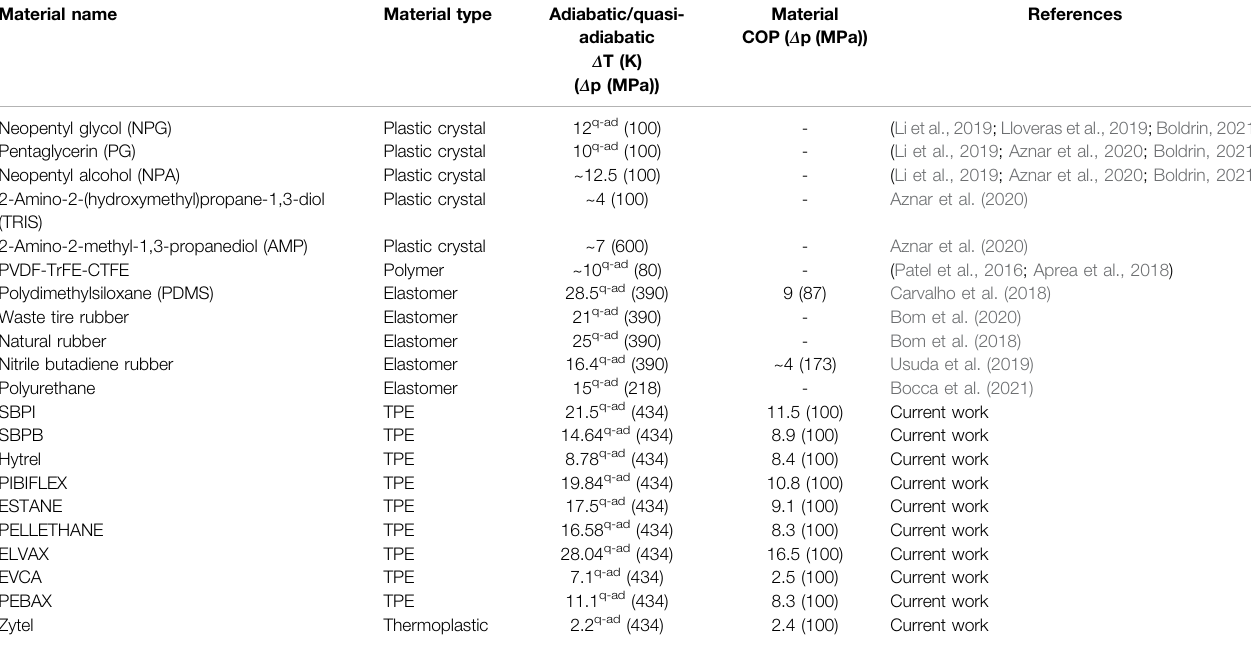
TABLE 2 | Comparison of the current work with previous studies on barocaloric properties of soft